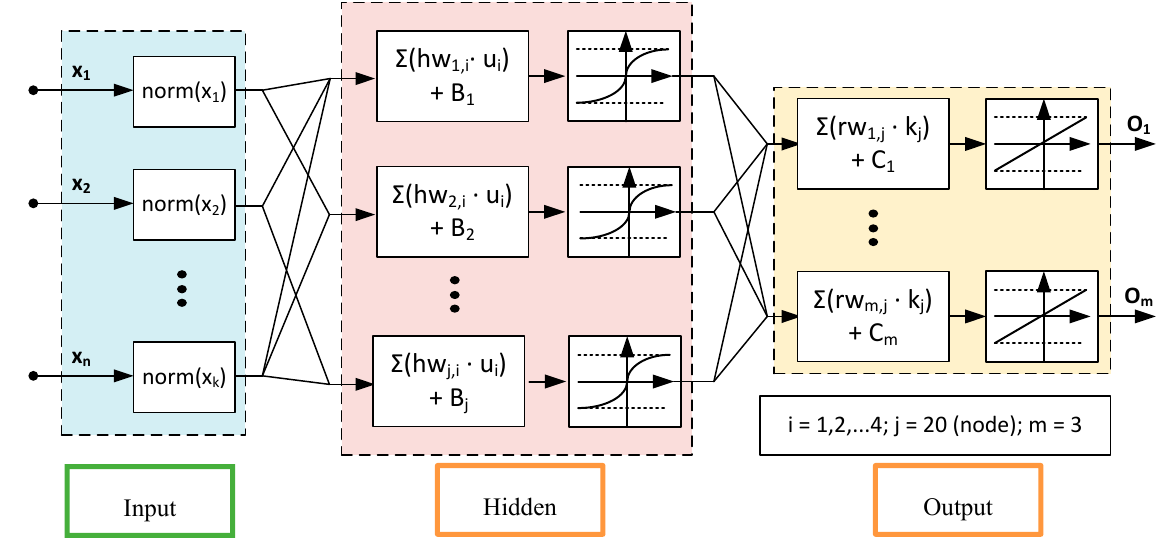
Figure 3. Schematic multi input multi output framework of a FANN model structure to predict the synthetic fuel production from pyrolysis of NRP.